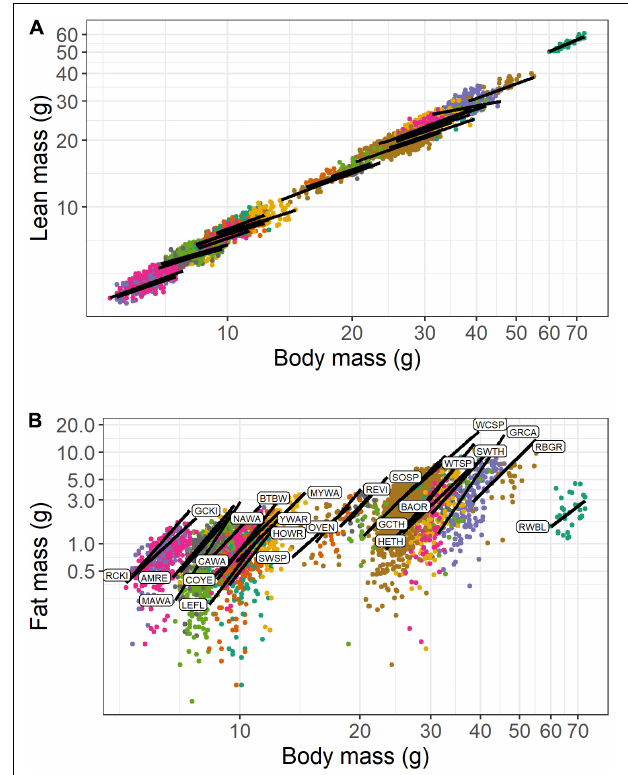
FIGURE 3 | Scaling of lean mass (A) and fat mass (B) with body mass for 25 species of songbirds stopping over at Long Point, Ontario ( n = 3,549). The lines show the linear mixed model predictions when year = 2009 and season = spring. Species codes are shown in panel B and defined in Table 1